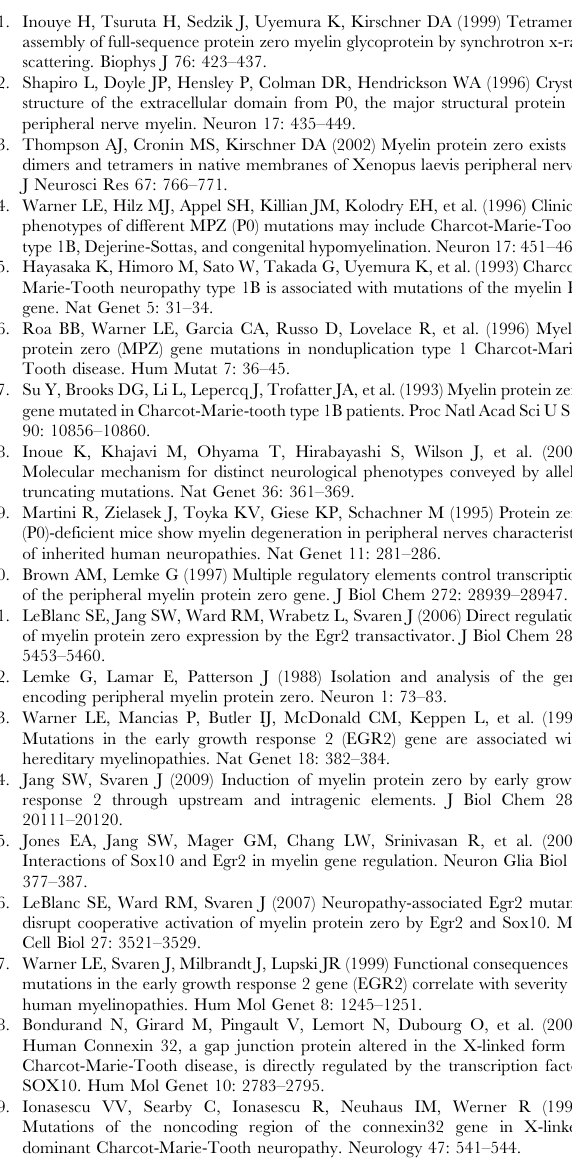
Figure S1 MPZ-MCS3 wild-type transgenic zebrafish embryos (7dpf) stained for EGPF (A-K) and acetylated tubulin (AcT in B,C,E,F,H, and I) and MBP (K and L). Panels A-C and J-K display the lateral view at the PLL ganglion region. Panels D-F represent lateral views showing trunk expression, whereas panels G-I show sympathetic chain expression from the ventro-lateral view; anterior is to the left; white arrowheads indicate PLL; white arrows indicate probable oligodendrocytes and blue arrows